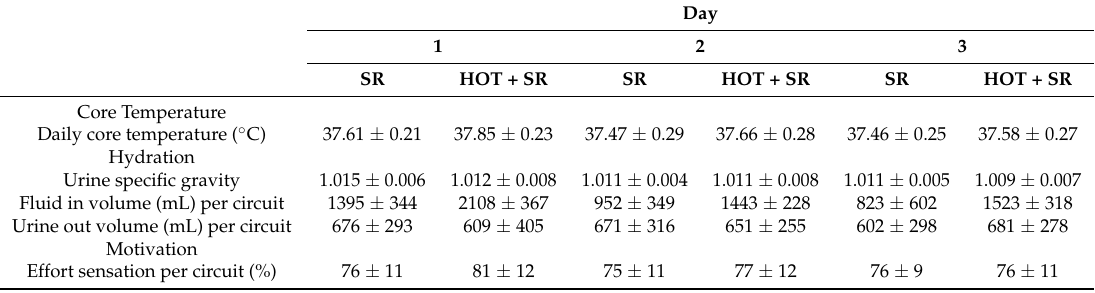
Table 4. Mean core temperature, hydration, and motivation for the SR and HOT + SR condition. Day 1 2 3 SR HOT + SR SR HOT +